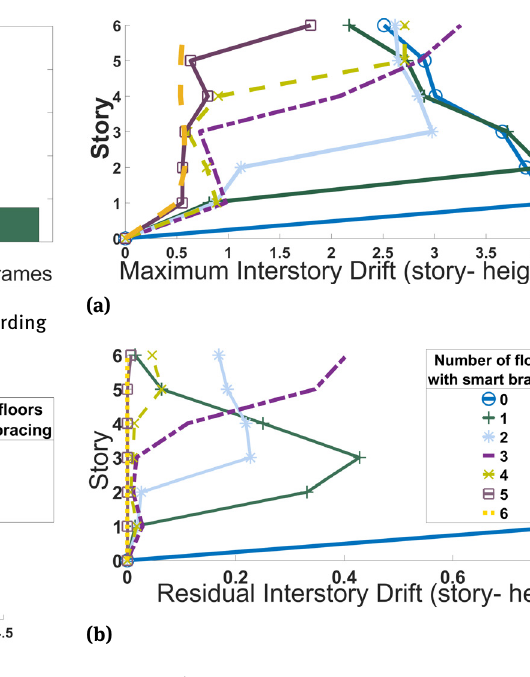
Figure 10: a) maximum interstory drift regarding the number of floors equipped with SMA braces along the height; (b) maximum residual interstory drift regarding the number of floors equipped with SMA braces along the